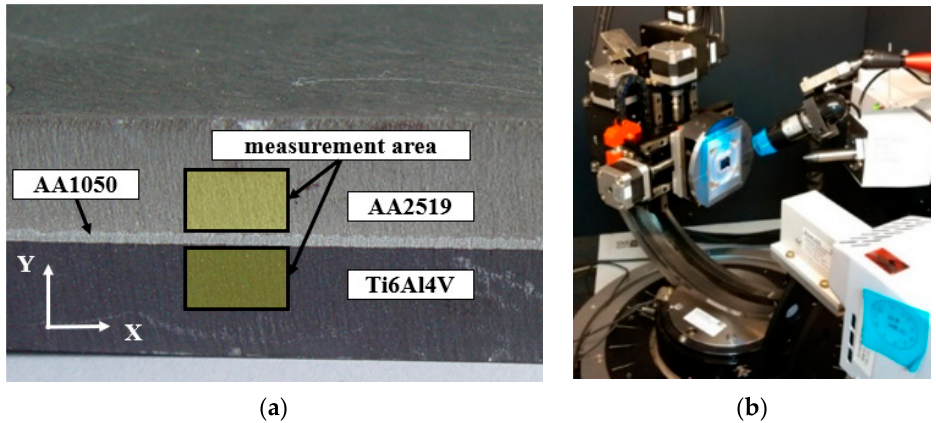
Figure 7. The surface area of the sample ( a ) and Bruker D8 Discover diffractometer with Euler wheel ( b ).